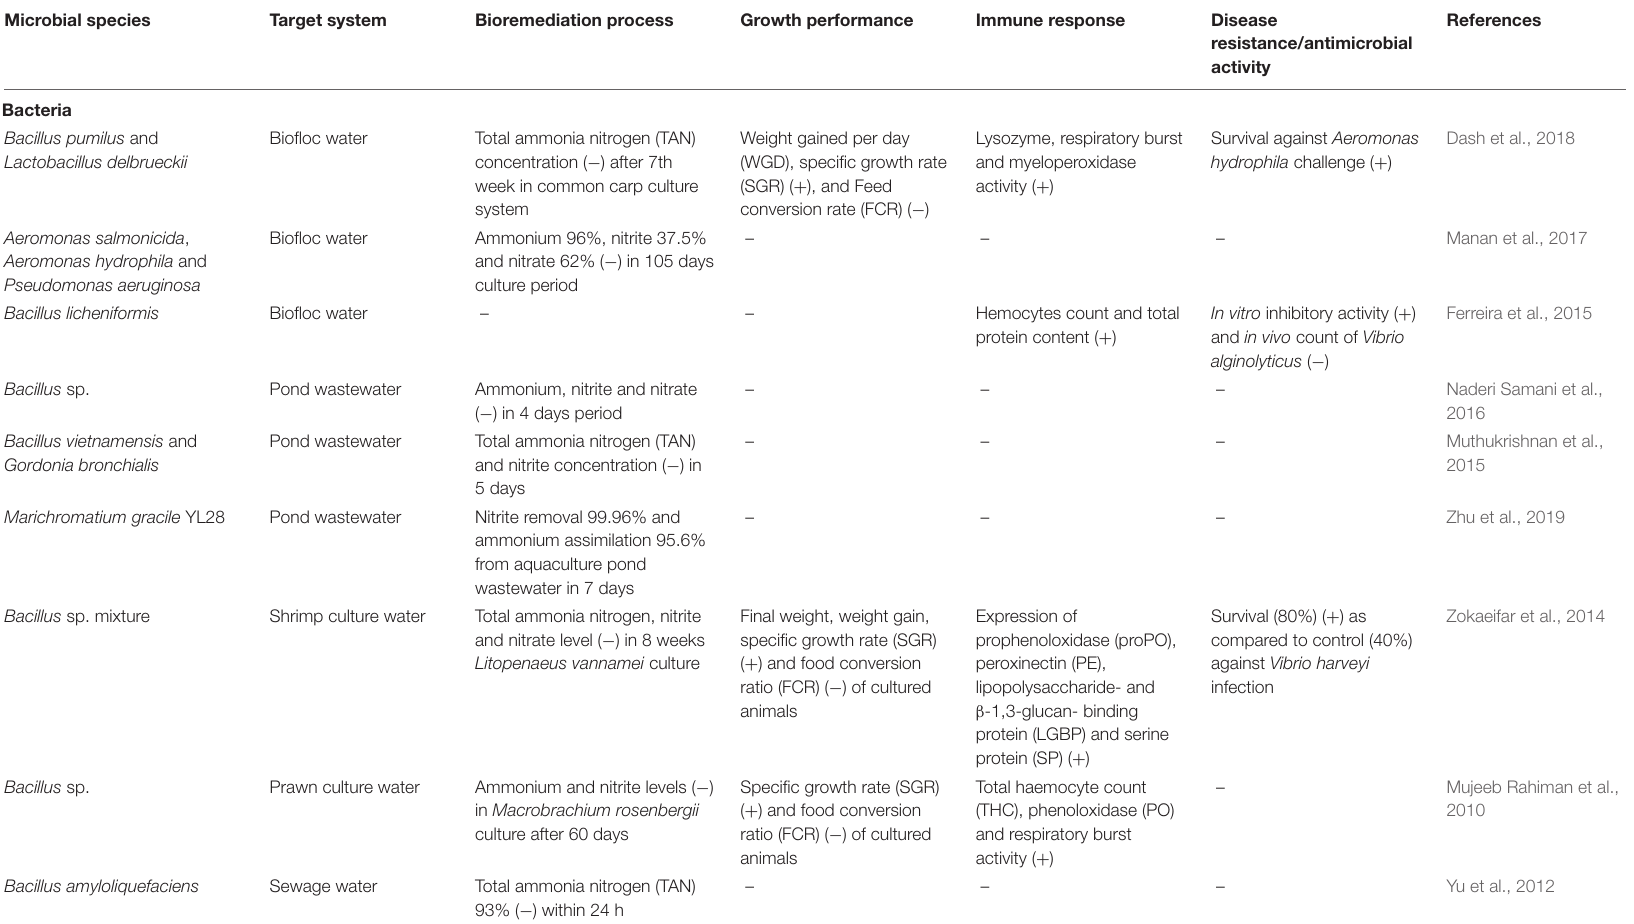
TABLE 2 | The list of microorganisms reported to be involved in the natural bioremediation process, growth, immunity, and disease tolerance of aquaculture